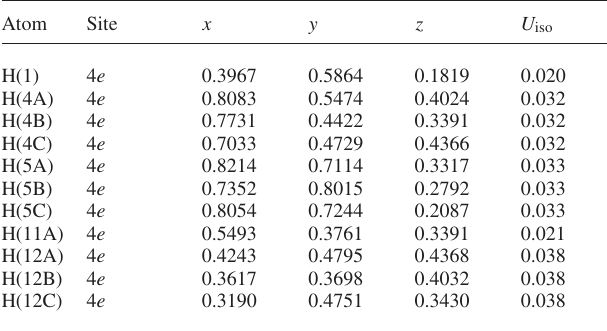
Table 2. Atomic coordinates and displacement parameters (in Å 2 )